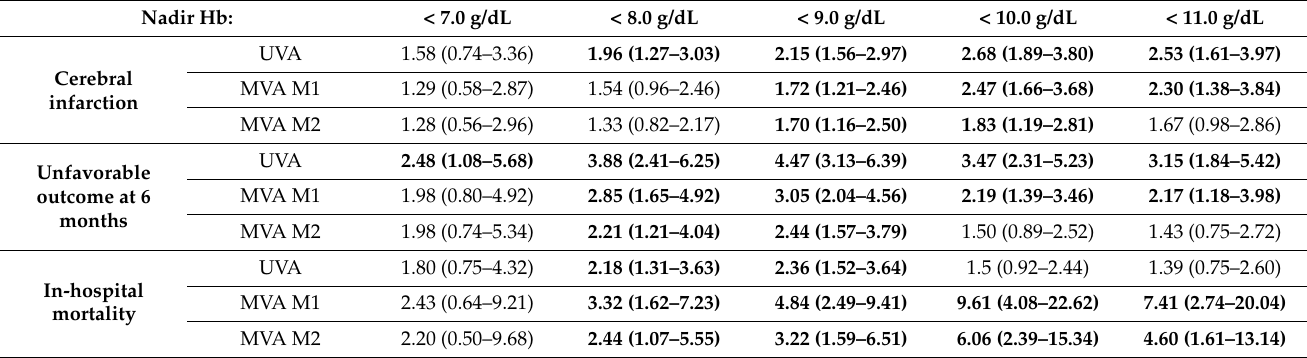
Figure 3. Occurrence of primary endpoints for the different degrees of anemia. There was a gradual increase in the rate of cerebral infarction, in-hospital mortality, and poor outcome for every nHb level decrease. Table 3. Overview of univariate and multivariate analyses for every nadir Hb